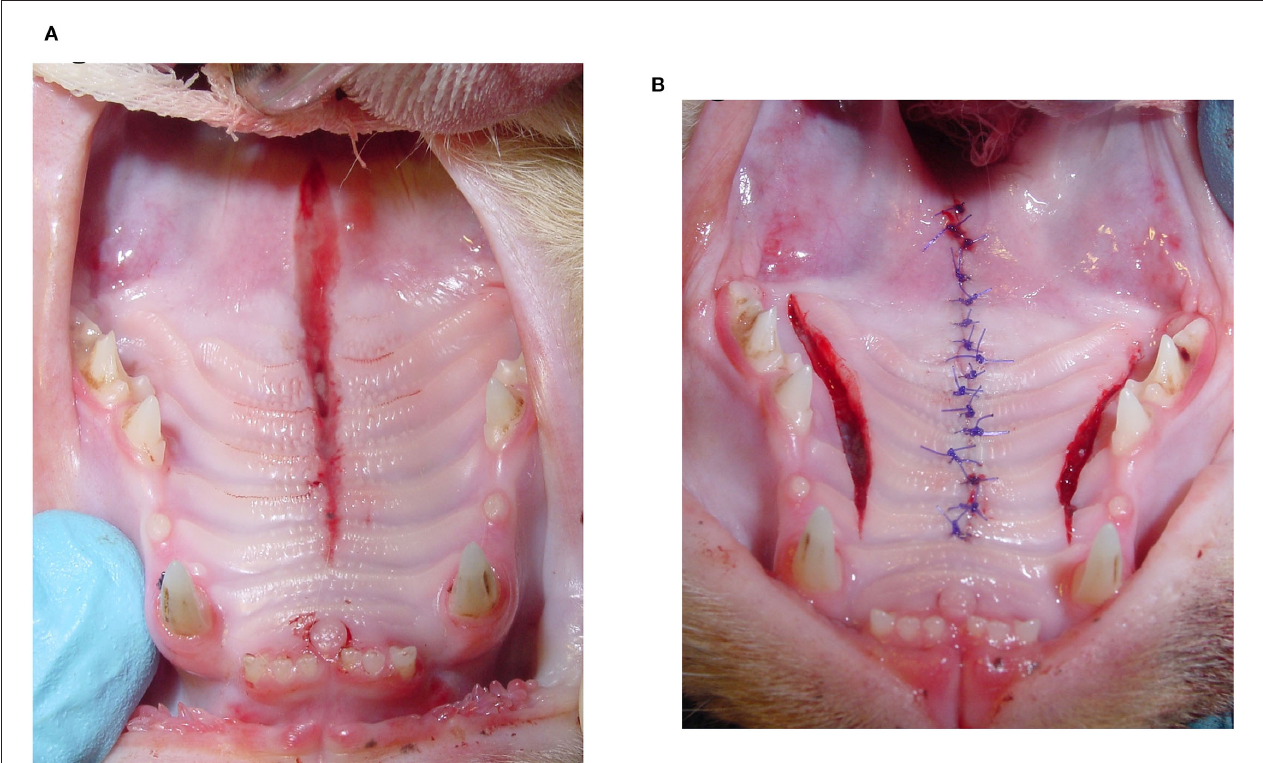
FIGURE 1 | Bilateral pedicle flap technique with lateral releasing incisions. (A) Acquired midline palate defect (PDE) extending from the level of the mesial aspect of the maxillary second premolar teeth to the rostral aspect of the soft palate. Increased interdental space between the right and left maxillary first incisor teeth is caused by separation of the median palatine suture. (B) Bilateral releasing incisions were made to elevate the right and left pedicle flaps. The PDE was sutured closed in a simple interrupted pattern.